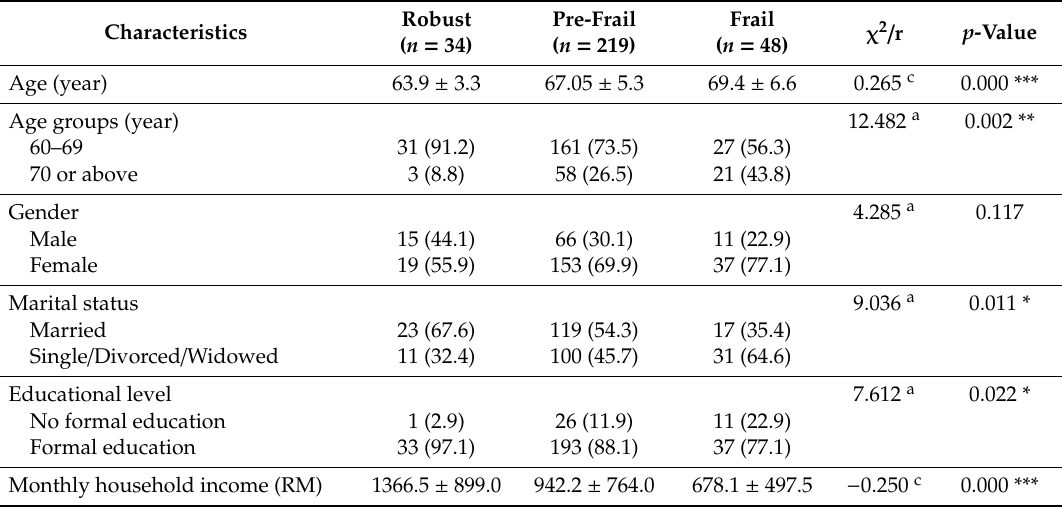
Table 2. Factors associated with the frailty